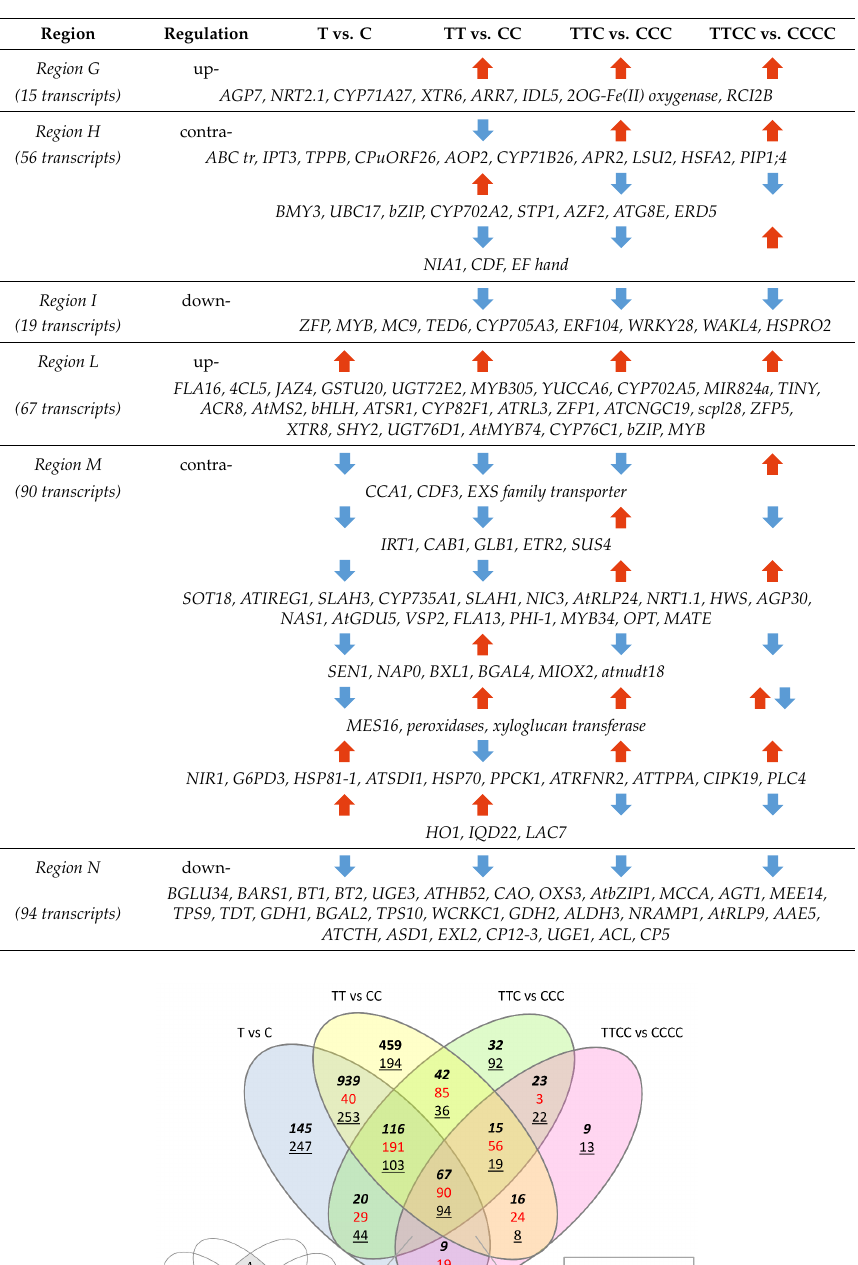
Table 3. Selection of the most annotated transcripts present in the Venn diagram regions G to N of Figure 5. All significantly modulated transcripts were filtered using Log 2 FC ≥ | 1.00 | as threshold in at least one of the comparisons. ( N = 3, q -value < 0.05). Red arrows, upregulated transcripts; blue arrows, downregulated transcripts; transcripts directly involved in N acquisition are shown in bold. For each region, the complete list and annotation of the genes is reported in Table S4.